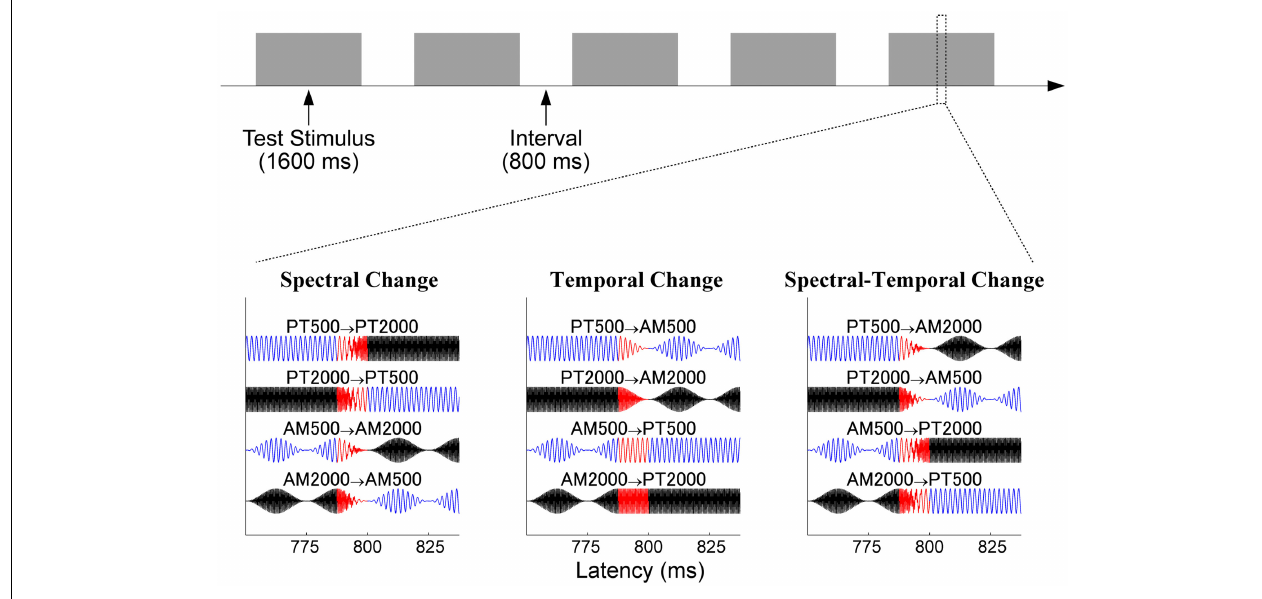
temporal change (TC: middle), and spectral–temporal change (STC: right) conditions. Blue and black lines represent 500 and 2000Hz, and red lines represent the sound change interval between 787.5 and 00ms after sound